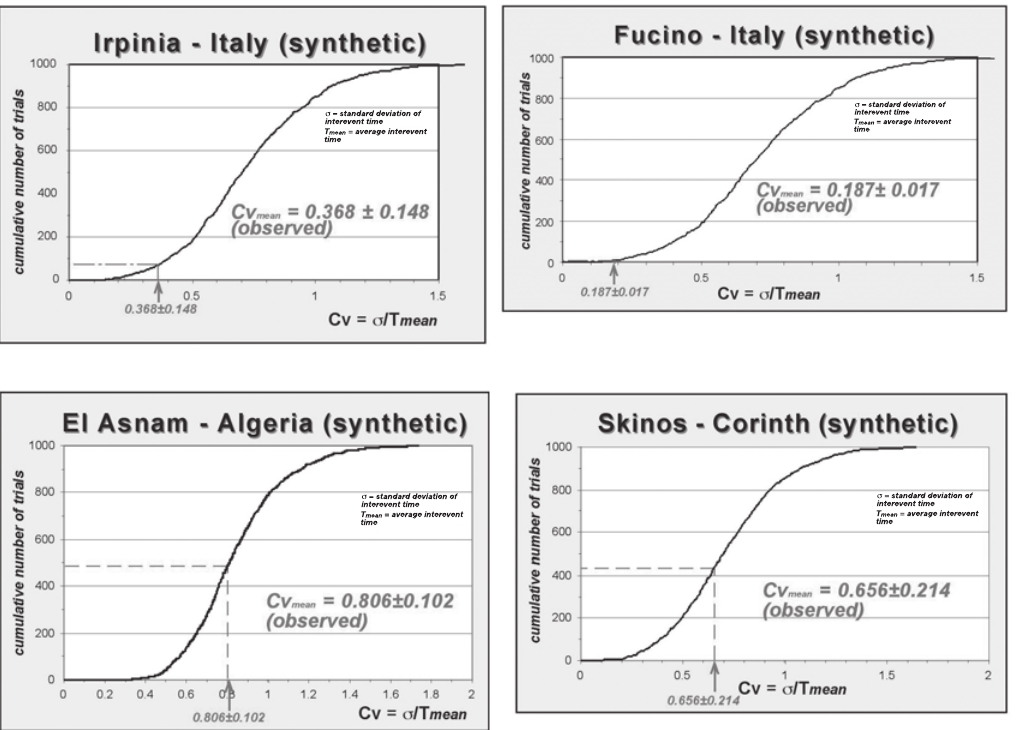
Fig. 5. Comparison between the synthetic random sets of recurrence and the observed Cv for each fault. This comparison allows us to derive the probability that the observed intervals are from a random distribution. The average of the coefficient of variation ( Cv ) and of the standard deviation of Cv for the fours faults are derived using a Monte Carlo procedure for 1000 inter-event sets randomly obtained by choosing the occurrence time of each event within the limits of uncertainty provided by the